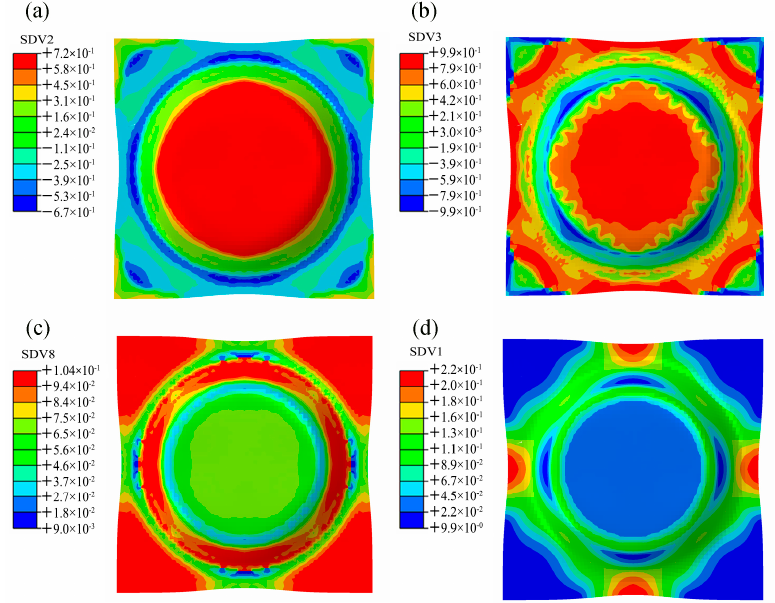
Figure 20. Marciniak simulation results when the stroke of the punch reaches 25 mm: ( a ) stress triaxiality; ( b ) Lode angle parameter; ( c ) retained austenite; ( d ) EPS.